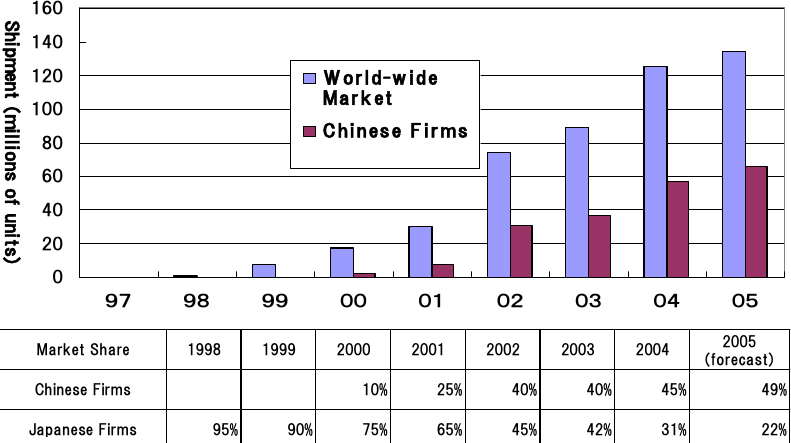
Figure 9. Rapid Progress of Chinese Firms in DVD Player Market